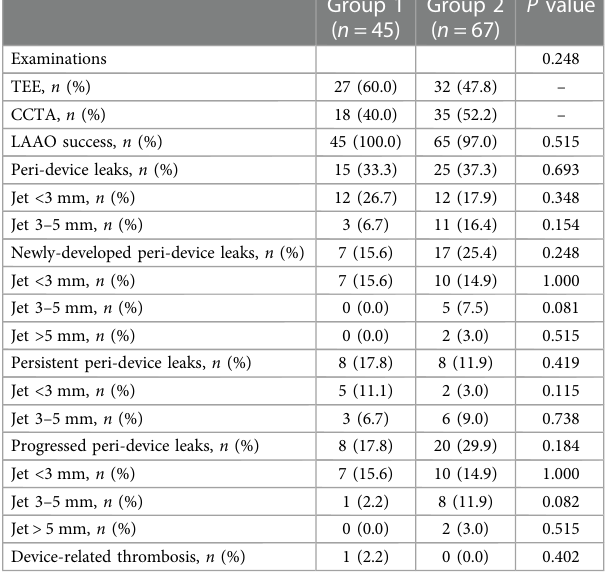
TABLE 3 Follow-up LAAO results.